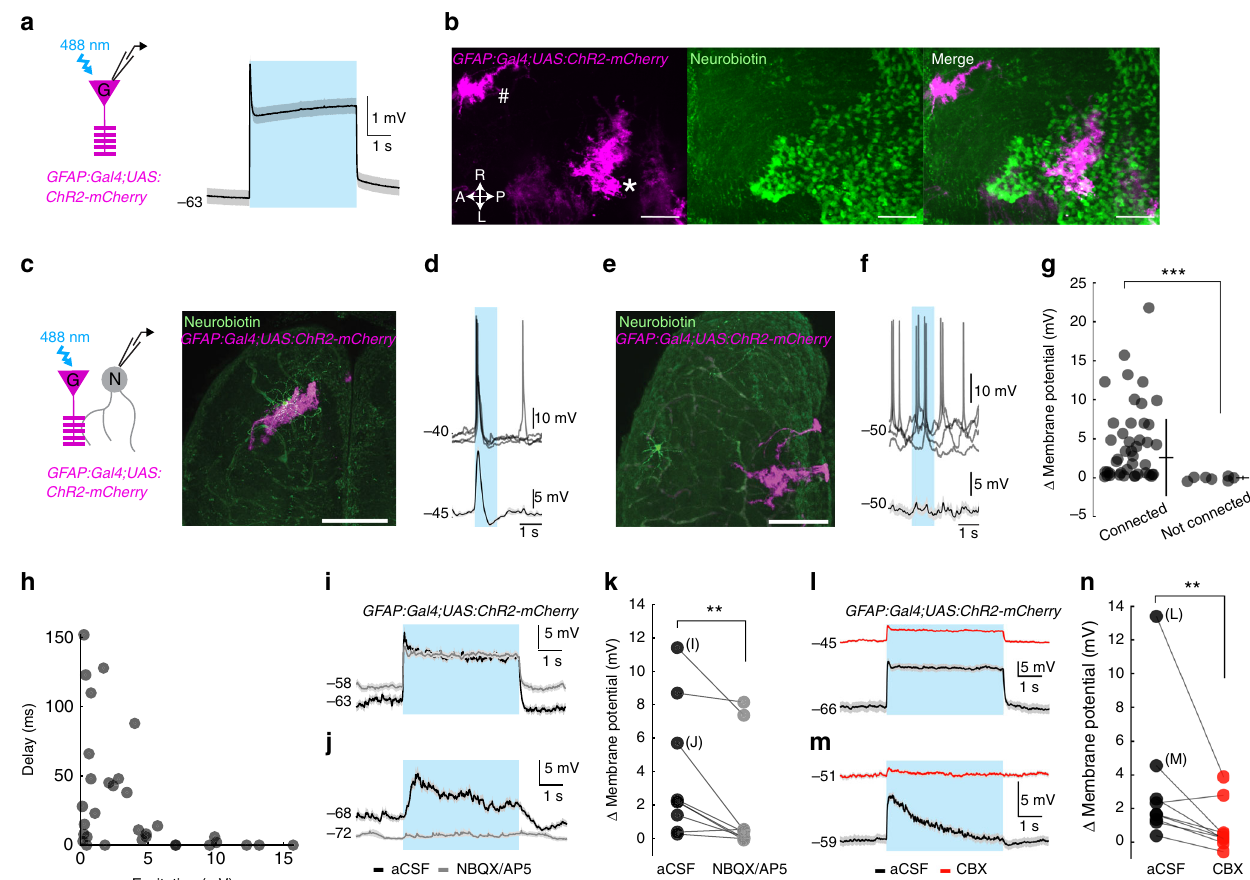
Fig. 6 Optogenetic activation of glial cells excites nearby neurons. a Scheme for patch-clamp recording of glial cells expressing channelrhodopsin2 (left). Average membrane potential of a representative optogenetically activated glia (right), n = 3 glia. b Zebra fi sh brain sparsely expressing channelrhodopsin2- mCherry in GFAP positive glial cells (magenta, indicated with * and #). A single glial cell fi lled with neurobiotin (green) using patch-clamp electrode, at location *. Note the neurobiotin coupling across glia. c , e Dorsal view of brain-explant preparation showing sparse expression of channelrhodopsin2 in GFAP positive glial cells (magenta), and individual neurons fi lled with neurobiotin (green) during intracellular recordings. d , f Membrane potential of example neurons with processes nearby channelrhodopsin2 expressing glial cells ( c , d ), or far away from channelrhodopsin2 expressing glial cells ( e , f ) during 1 s optogenetic stimulation (blue shade). Overlaid sweeps (top) and 30 Hz low-pass fi ltered and averaged membrane potential (bottom). g Average change in membrane potential of neurons during the fi rst 300 milliseconds of optogenetic stimulation of glial cells. n = 43 connected, n = 7 not connected neurons. h Distribution of excitation amplitude and excitation delay of connected neurons, upon optogenetic activation of glial cells. n = 43 connected neurons. i , j Examples of neurons with fast ( i ) and slow ( j ) excitation upon optogenetic activation before (black) and after (gray) addition of ionotropic glutamate receptor blockers NBQX (5 μ M) and AP5 (25 μ M). k Average change in membrane potential of neurons during fi rst 1 sec of optogenetic stimulation of glial cells, before and after the addition of NBQX and AP5, n = 9 neurons. l , m Examples of neurons with fast ( l ) and slow ( m ) excitation upon optogenetic activation before (black) and after (red) addition of gap junction blocker carbenoxolone (CBX, 100 μ M). n Average change in membrane potential of neurons during the fi rst 1 s of optogenetic stimulation of glial cells, before and after addition of carbenoxolone, n = 9 neurons. ** p = < 0.01, *** p = < 0.001, Wilcoxon ranksum ( g ) or sign-rank test ( k , n ). Shaded regions denote s.e.m. of 25 repetitions ( a , d , f , i , j , l , m ), error bars denote mean ± s.d. ( g ).